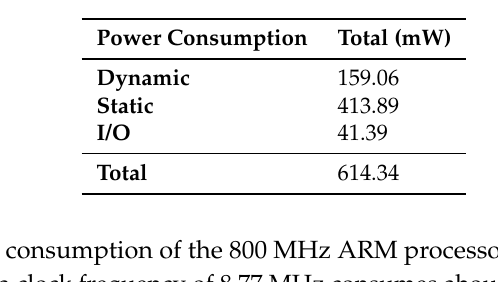
Table 10. Power consumption for the entire implementation.